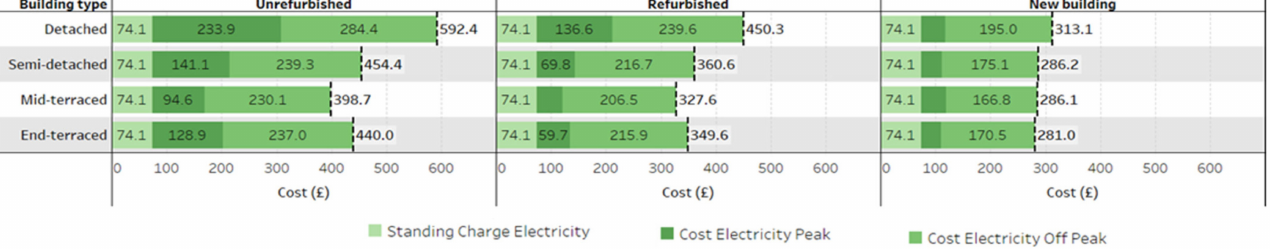
Figure 12. Heating energy cost for heat pump uptake scenarios by house archetypes from Comfy Heat